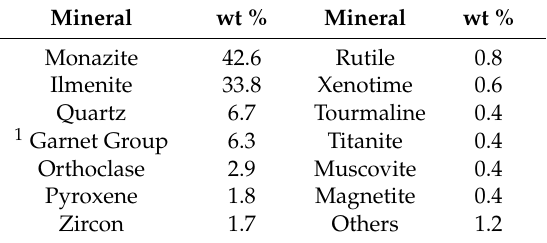
Table 1. Feed sample mineralogy (wt %) analyzed by mineral liberation analysis (MLA).